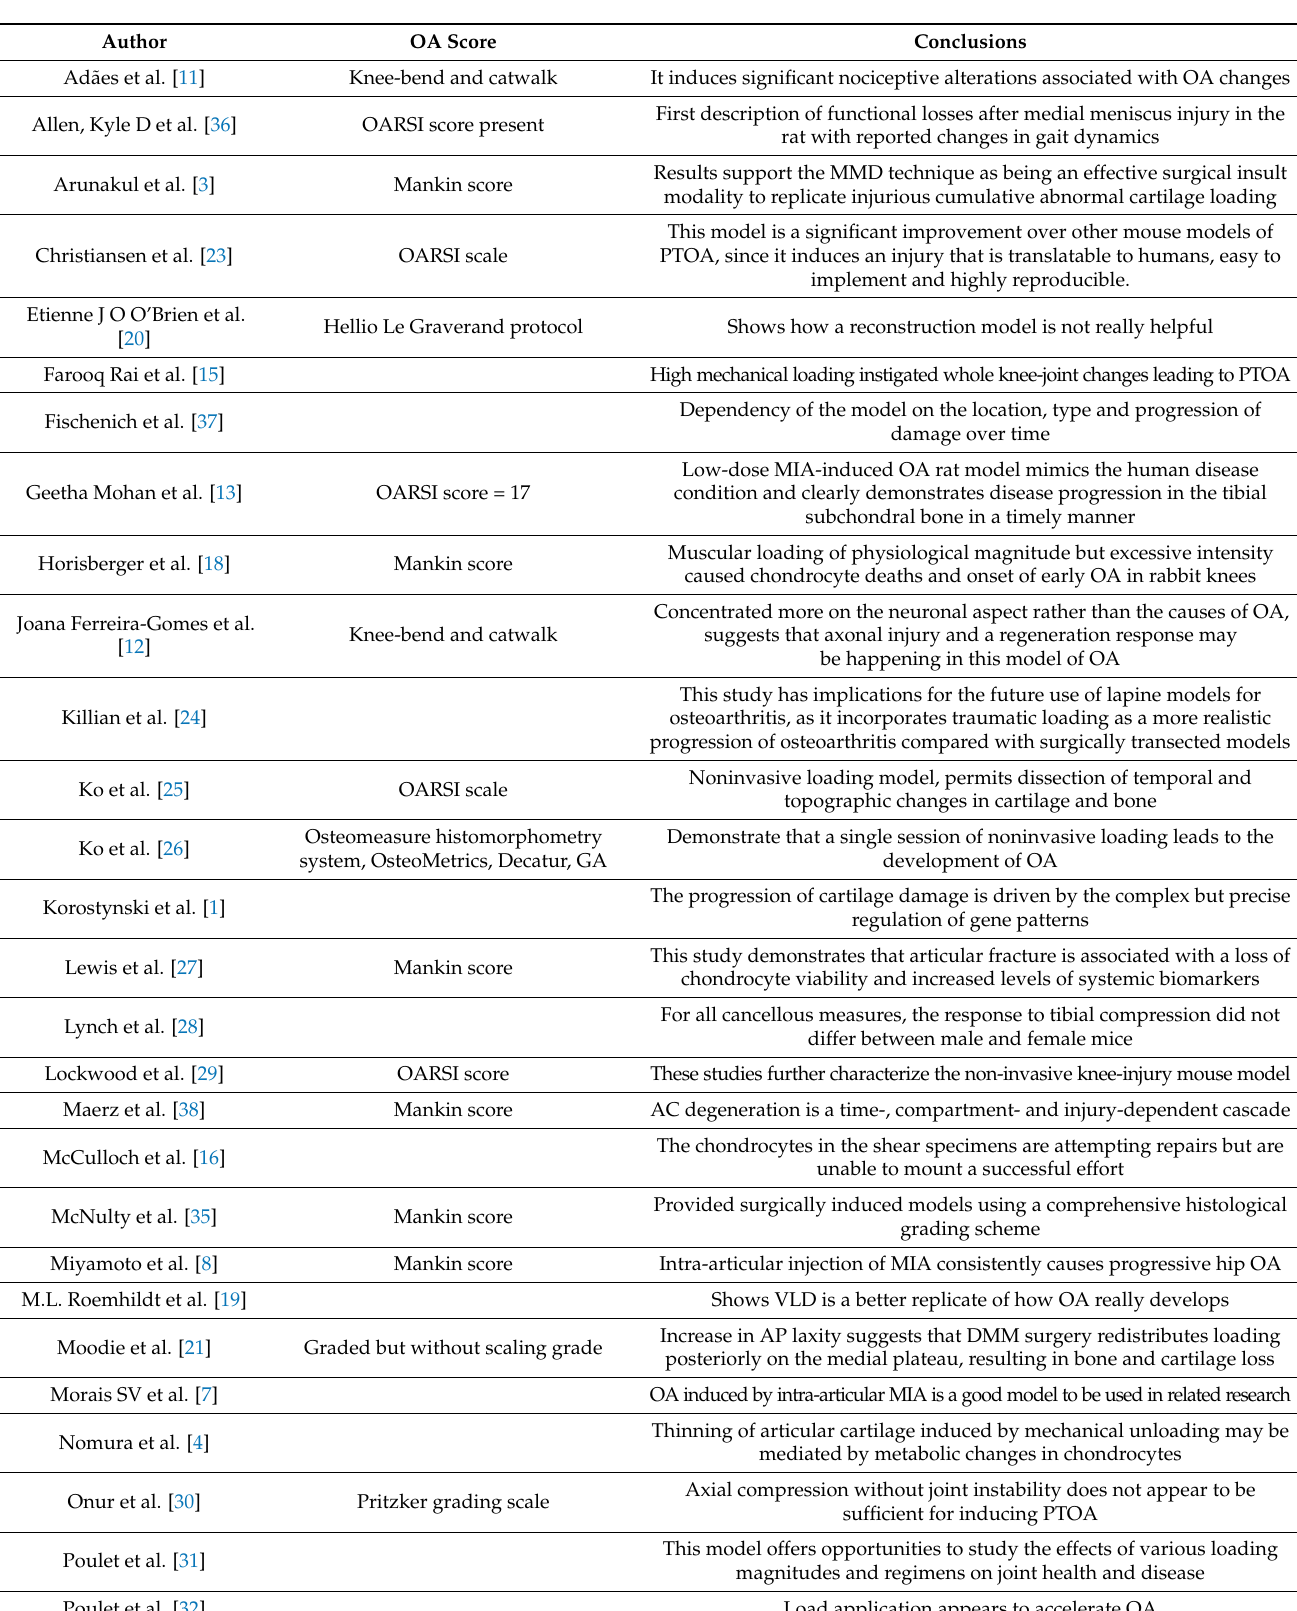
Table 2. Type of induction and joint